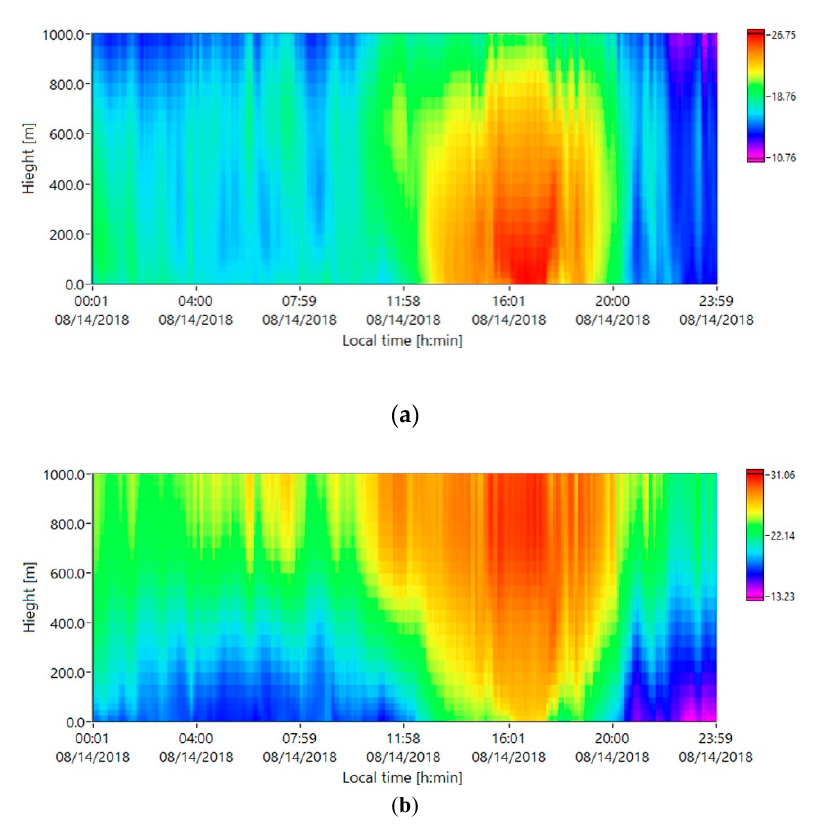
Figure 3. Diurnal variations of ( a ) temperature and ( b ) potential temperature in degrees Celsius on 14 August 2018.